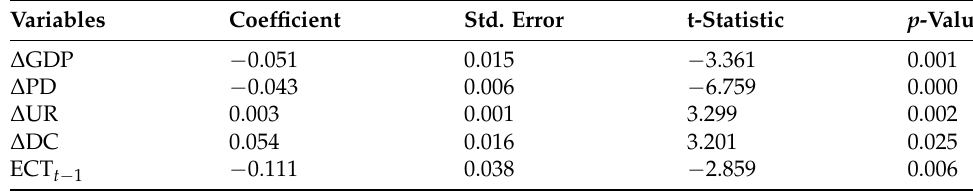
Table 5. Short-run